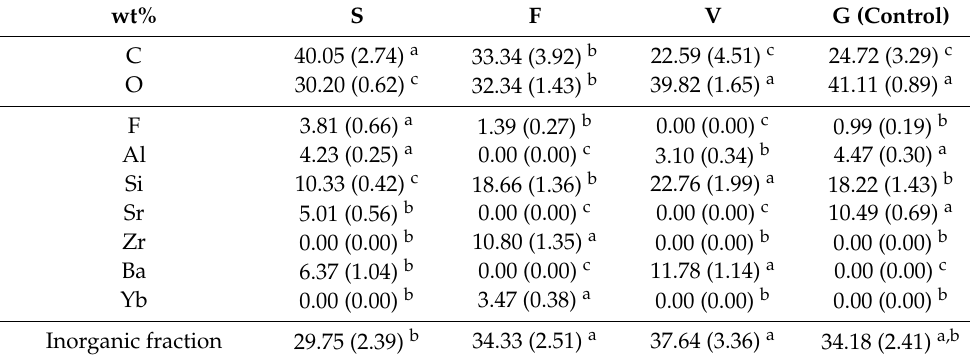
Table 2. Energy-dispersive X-ray spectroscopy (EDS) compositional analysis of specimens’ surface layer after finishing and before microbiological challenges. Means ( ± 1 SD) are displayed. Inorganic fraction is depicted as the sum of all elements constituting the fillers, as opposed to the organic matrix evidenced by the carbon content. Two-way ANOVA showed that material, not curing time factor, was highly significant ( p < 0.0001); therefore, results are provided as the average composition for each material. Different superscript letters indicate significant differences between materials (Tukey’s test, p < 0.05) for a given